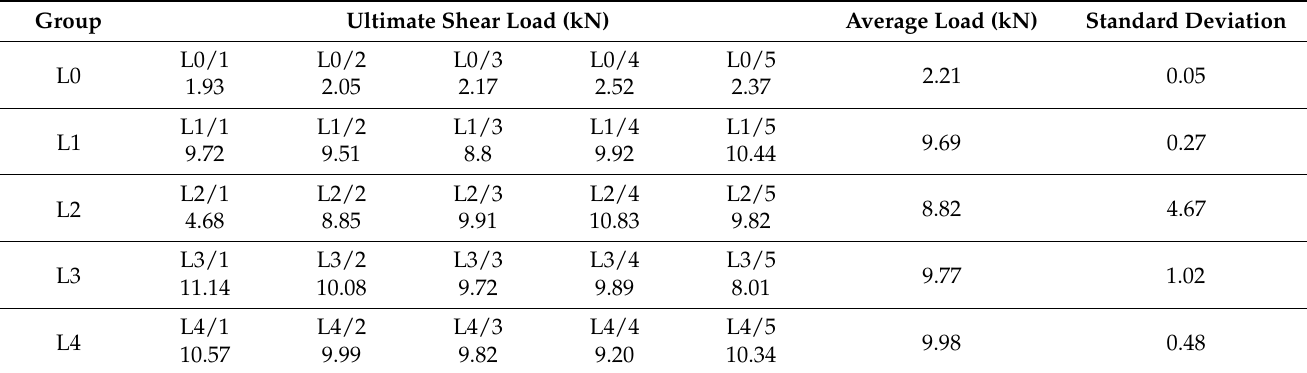
Table 7. Experimental data of the tensile strength of